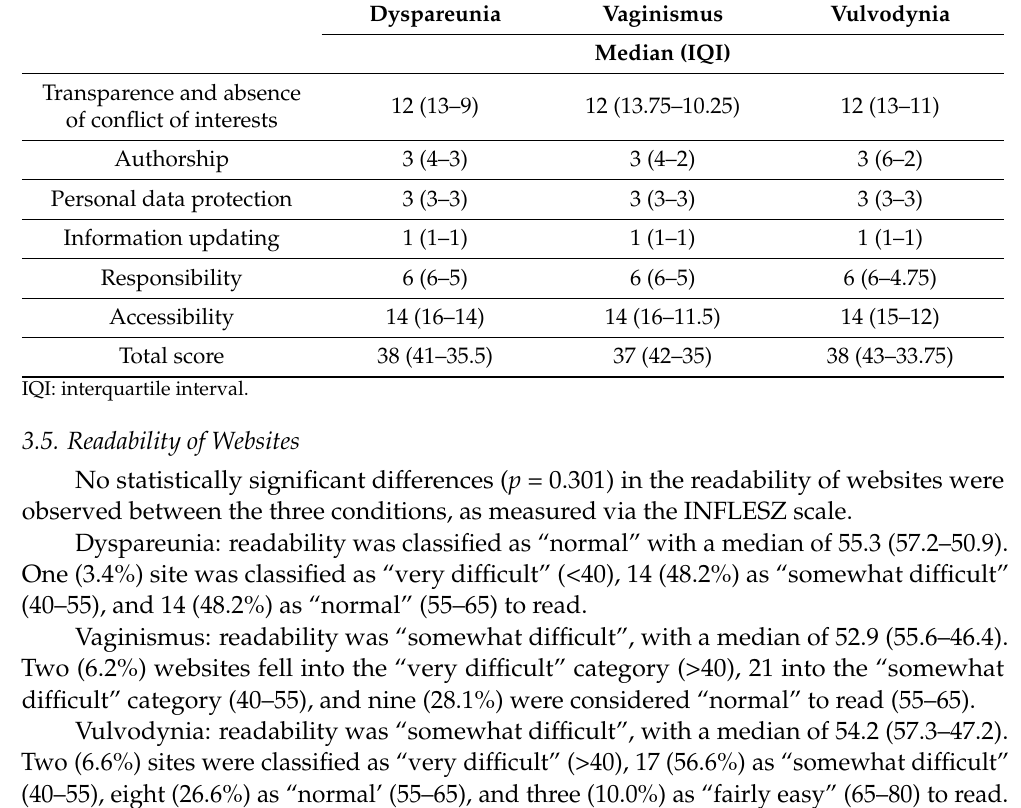
Table 2. Distribution of scores, overall and by categories, for website quality according to the Berm ú dez-Tamayo questionnaire. Dyspareunia Vaginismus